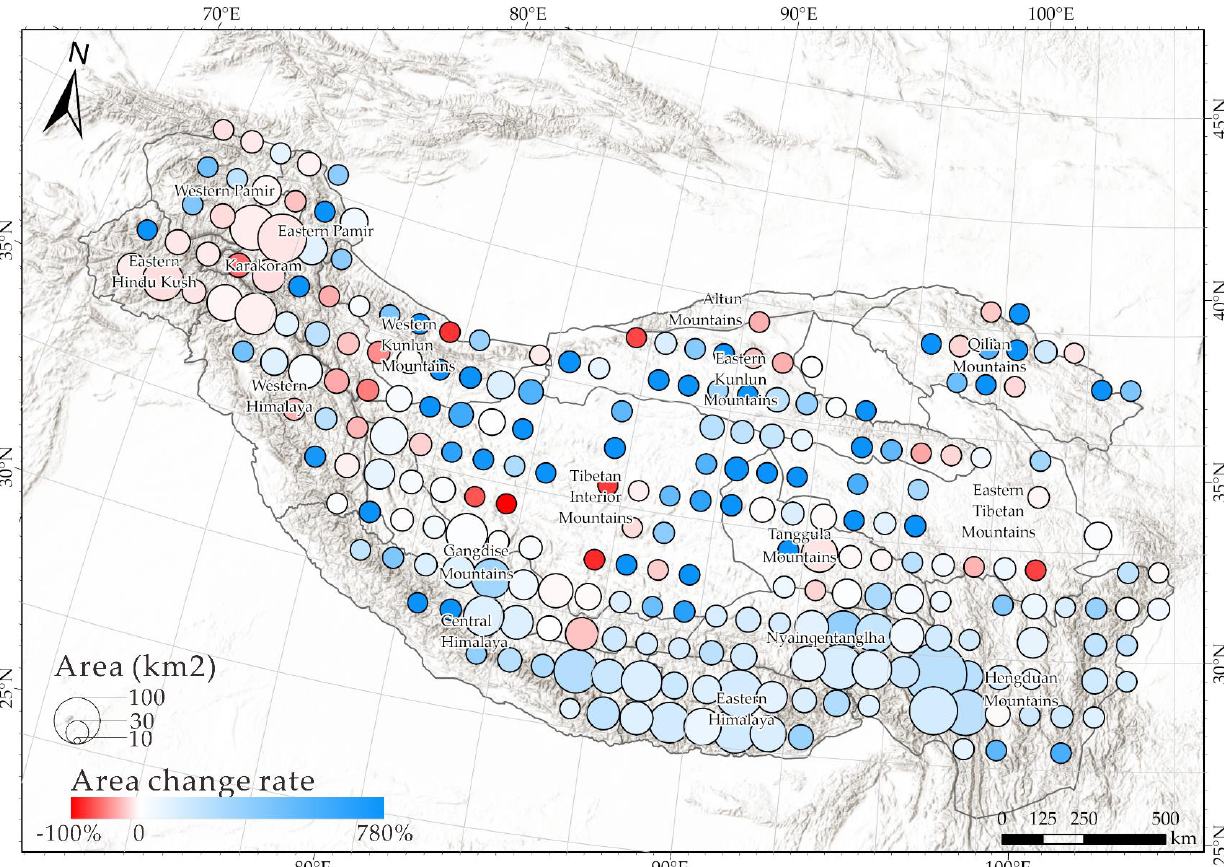
Figure 7. Altitudinal characteristics of various types of glacial lake areas in 2013–2019. The width of the colored pattern in the figure represents the area of different types of glacial lakes at different altitudes. The wider the pattern, the larger the area.